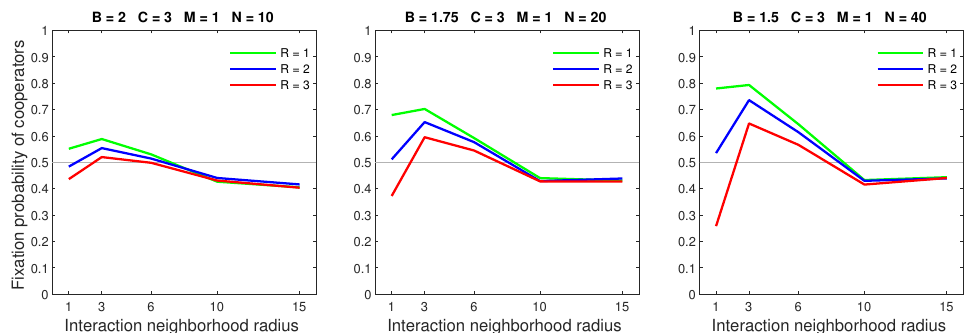
Figure 5. In the random dispersal model, increasing the dispersal range for a low mobility rate ( M = 1) reduces the fixation probability of cooperators in small neighborhoods, especially when D = 1.